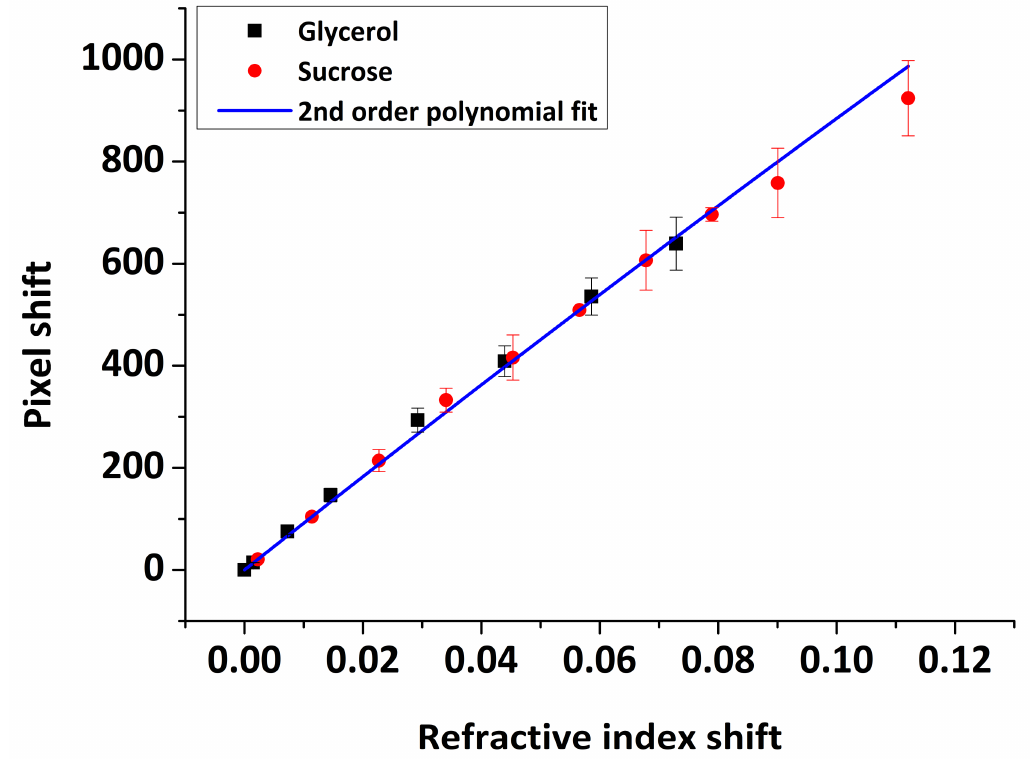
Figure 11. Pixel shift versus normalized (to pure water) refractive index shift for glycerol / sucrose